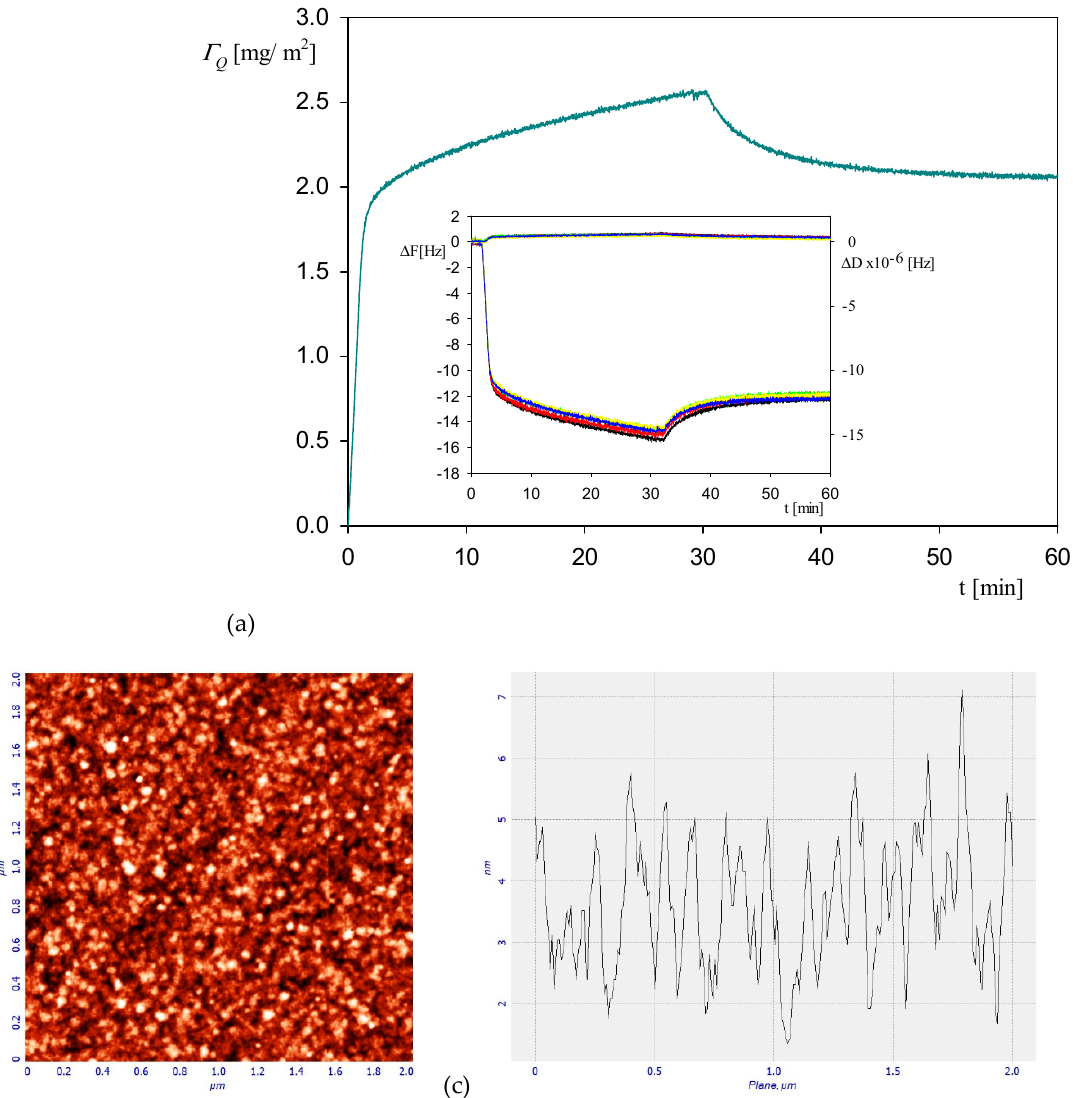
Figure 6. Part ( a ) the kinetic of myoglobin adsorption on silica sensor determined by QCM, flow rate 2.5 × 10 − 3 cm 3 s − 1 , bulk protein concentration equal to 10 mg L − 1 , 0.15 M NaCl, pH 3.5. At the time of 35 min the rinsing run was initiated by flushing pure electrolyte at the same ionic strength and pH. The inset shows the primary frequency shift Δ Fq (left hand axis) and dissipation Δ D (right hand axis) as a function of time at the following overtones: ● —3rd, ● —5th, ● —7th, ● —9th, ● —11th. Part ( b ) the AFM image of the silica sensor with adsorbed myoglobin molecules. Part ( c ) the height profile of the protein layer adsorbed at the sensor